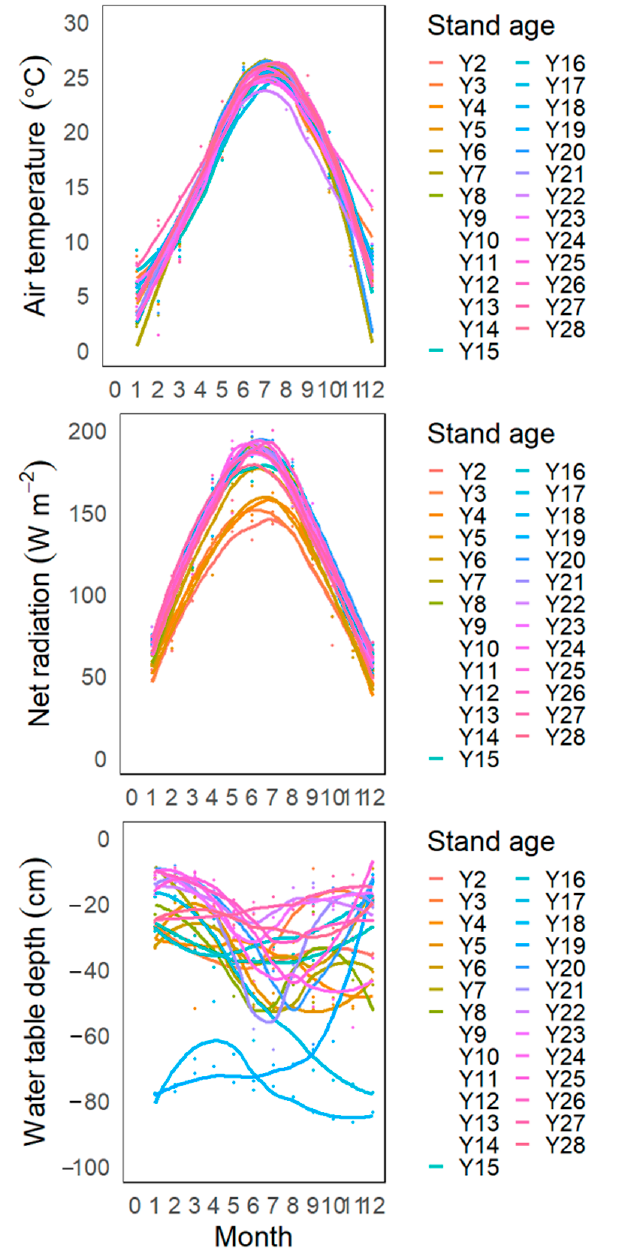
Figure 2. Interannual and seasonal trends in climate variables along the chronosequence sites (YP and MP). Different color lines indicate stand age. Different color circles represent monthly data each year.